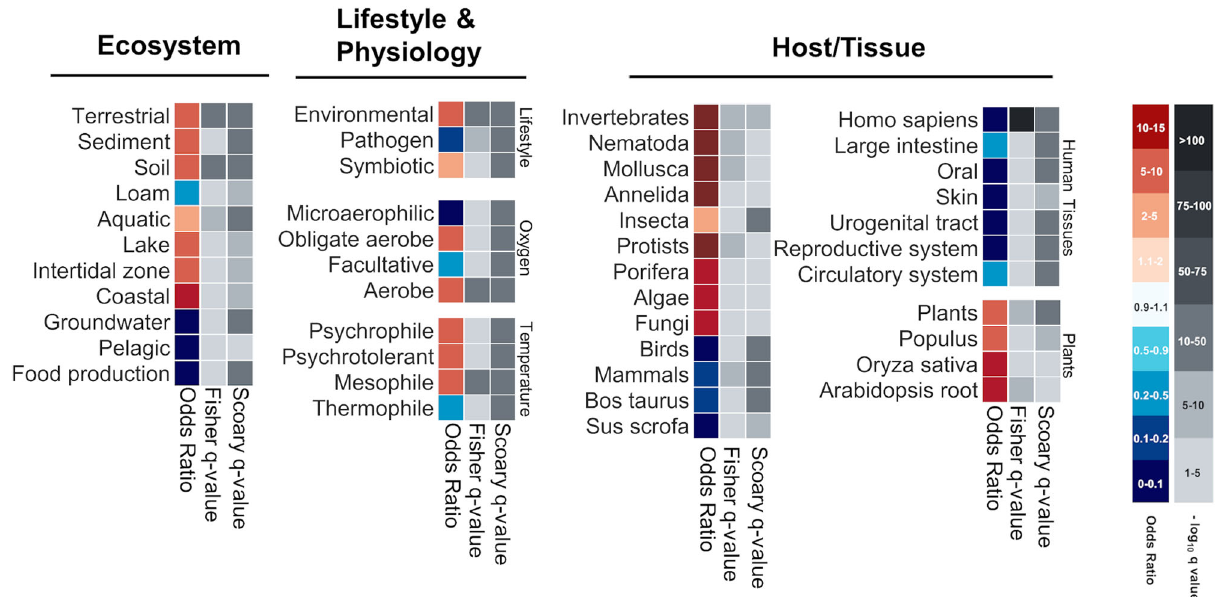
Fig. 2 eCIS-encoding microbes ’ lifestyle and isolation. A Fisher exact test combined with a modi fi ed version of Scoary was used to perform a phylogeny- aware analysis of eCIS-encoding microbes ’ metadata. The Odds Ratio represents the enrichment or depletion magnitude, with hotter colors representing enrichment, and colder colors representing depletion. The negative log10 of the q -values, shown in shades of gray, are corrected for multiple hypothesis testing. One q -value corresponds to the statistical signi fi cance of a two-sided Fisher exact test, and the other represents the same for the Scoary pairwise comparison test. Source Data are provided in Supplementary Data